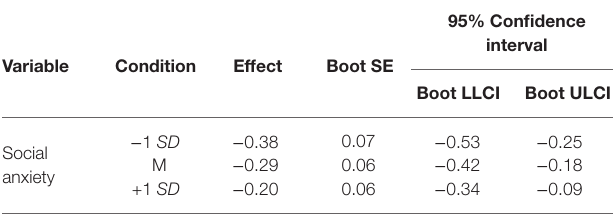
TABLE 6 | Conditional indirect effect of collective efficacy.